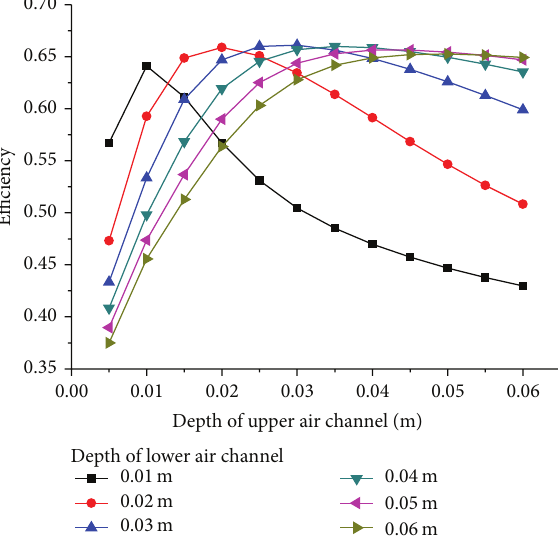
Figure 13: Effect of depths of air channels on the efficiency of the collectorinairheatingmodewiththeinsulationthicknessof0.06